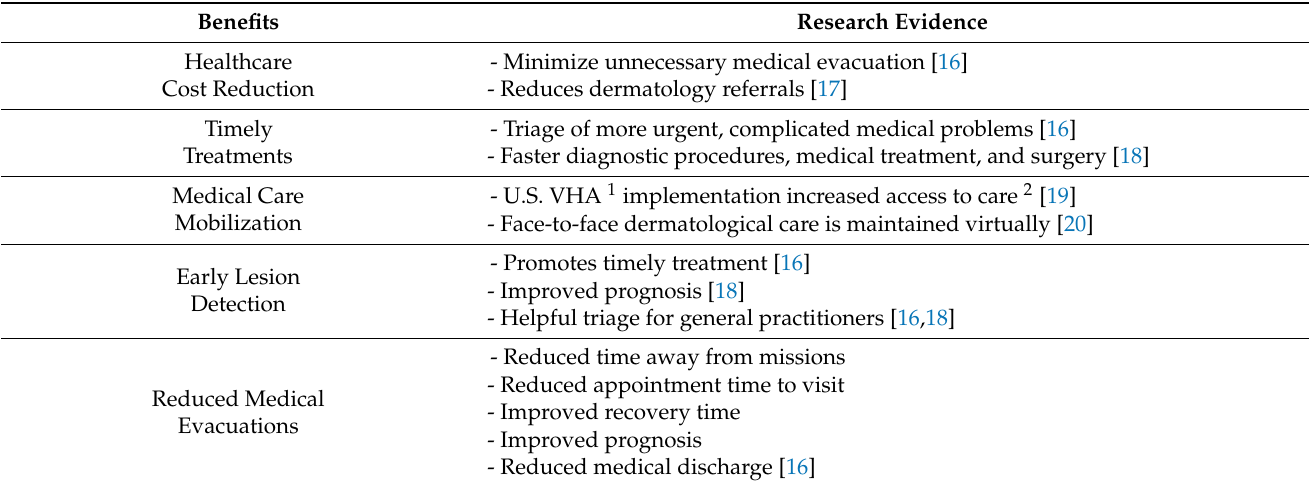
Table 1. Evidence of Teledermatology Benefits in Military